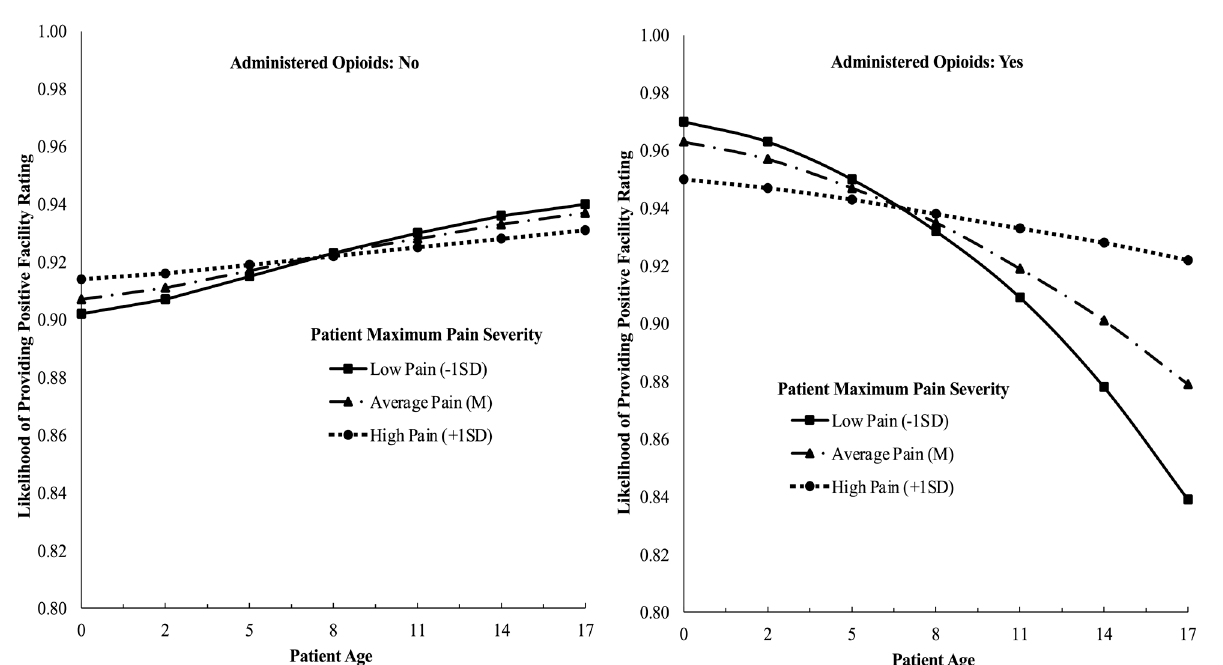
Figure 1. Three-way interaction of age, pain severity, and opioid administration on parent likelihood to provide a positive facility rating controlling for all other demographic, clinical, and top diagnosis covariates. Age by pain severity interactions were graphed for patients were not given an opioid (left) and for those that were administered an opioid